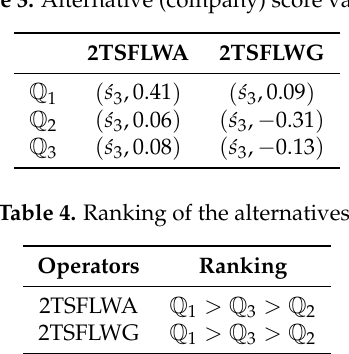
Table 3. Alternative (company) score values.